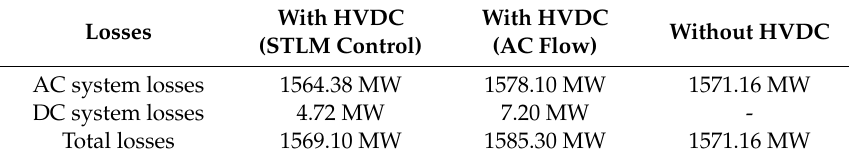
Table 6. Comparison of system losses by operating method.